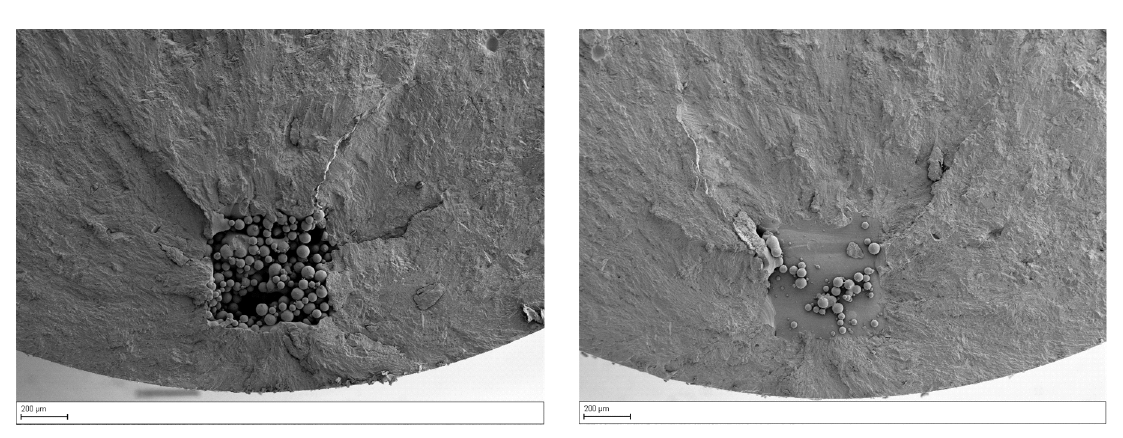
Figure 5. Typical failure location of Ti6Al4V samples at the first not melted layer. Top ( left ) and bottom ( right ) half on the same test coupon.